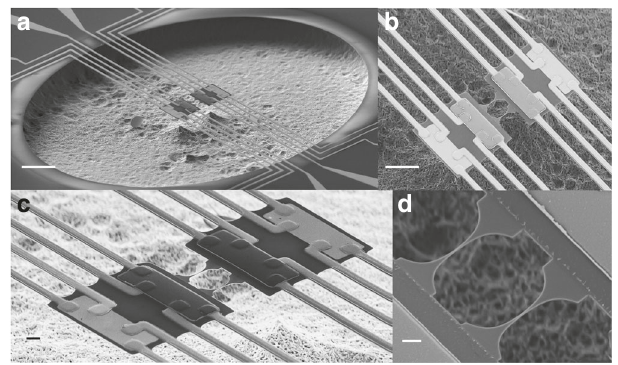
Fig. 1 Suspended silicon nitride measurement platform. a Scanning electron microscopy (SEM) images of the fully suspended silicon nitride membrane- based nanocalorimeters designed for very low temperature measurements. Scale bar, 20 μ m. b , c Ensemble view of the nanocalorimeters with, for each membrane, a copper heater and a NbN thermometer. The thermometers have been purposely installed to probe the temperature very close to the 1D nanowires. A four-contact geometry on the heaters and thermometers allows for highly sensitive electrical measurements of the thermal properties. The two membranes are thermally interconnected via the 1D nanowires. Scale bars are 10 μ m in b and 2 μ m in c . d Top view of the nanowires obtained by e-beam lithography. The connection of the 1D nanowires to the reservoirs has a catenoidal shape to optimize the value of the transmission coef fi cient 9 . Scale bar, 1 μ